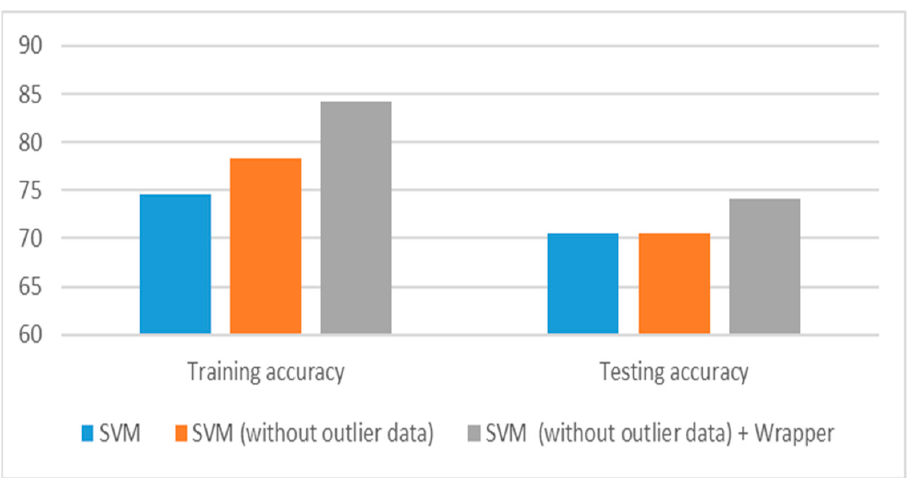
Figure 2. The classification accuracy of the SVM algorithm through the proposed system phases to predict the total infected cases.